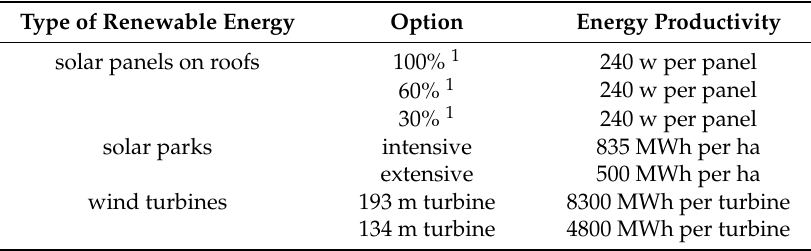
Table 4. Renewable-energy options in the COLLAGE tool for